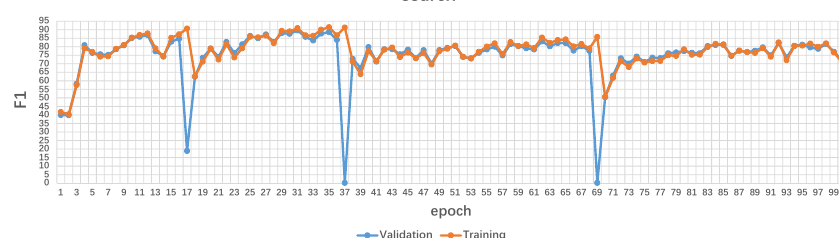
Figure 10. The effect of channel pruning on SSDD: pruning is triggered 3 times. As the scenarios in SSDD are simpler, overfitting is not as serious as what was achieved with HRSID. However, F1 validation score recovers quickly after a few epochs of